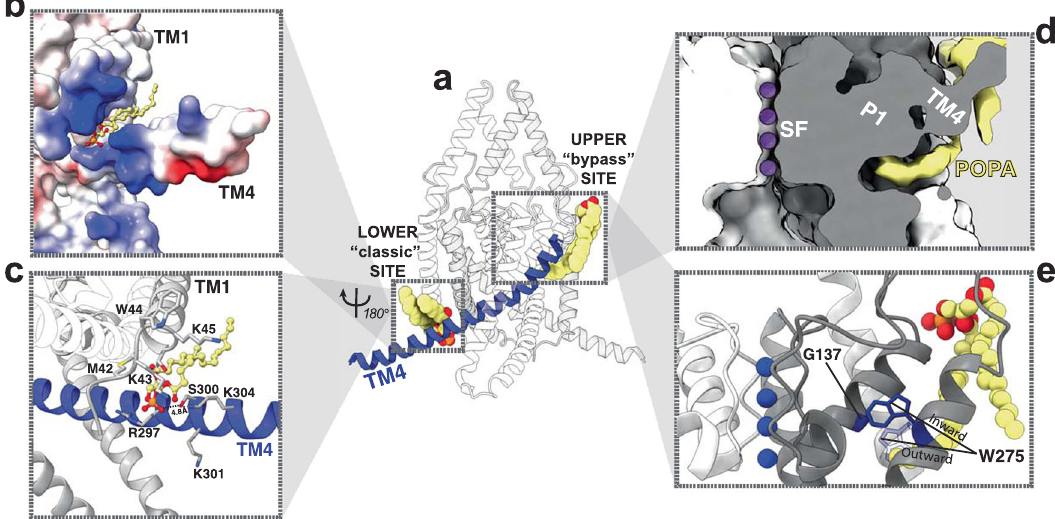
Fig. 4 | Molecular details of the POPA lipids binding sites. The upper and lower POPAbindingsitesidenti fi edinthecryo-EMdensitymap fl anktheTM4helix( a ).At the lower site ( b , c ), the well-resolved POPA headgroup sits in a groove between TM1 and TM4. A coulombic potential surface representation of the lower site ( b ) with a molecular representation shown in ( c ), demonstrates the strong electro- positive nature of the lower binding site. At the upper site ( d , e ), the cryo-EM